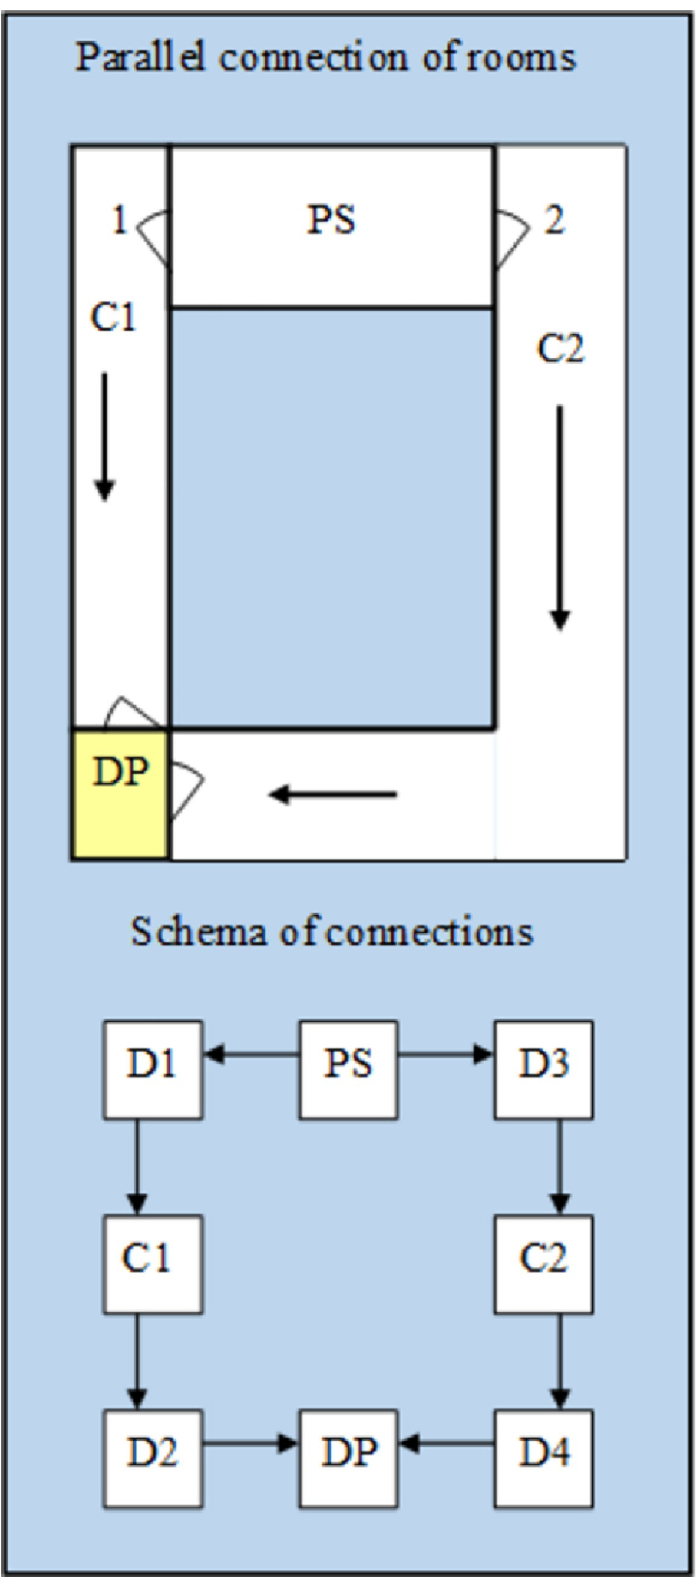
Fig 5. Parallel connection of rooms and their schema. C- corridors, D- doors, DP-destination point, PS- public space . https://doi.org/10.1371/journal.pone.0255993.g005 PLOS ONE | https://doi.org/10.1371/journal.pone.0255993 August 9,